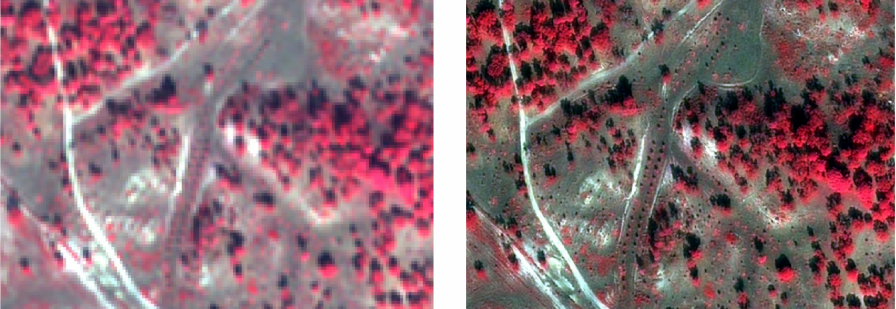
Figure 2. False-color composite of the multispectral image acquired in 2018 ( left ) and the correspond- ing pan-sharpened image ( right